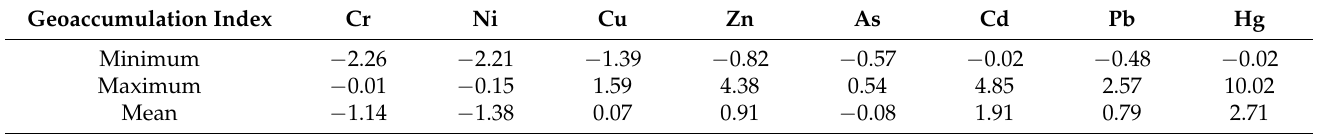
Table 5. Heavy metals’ Geoaccumulation Index (I geo ) in road dust